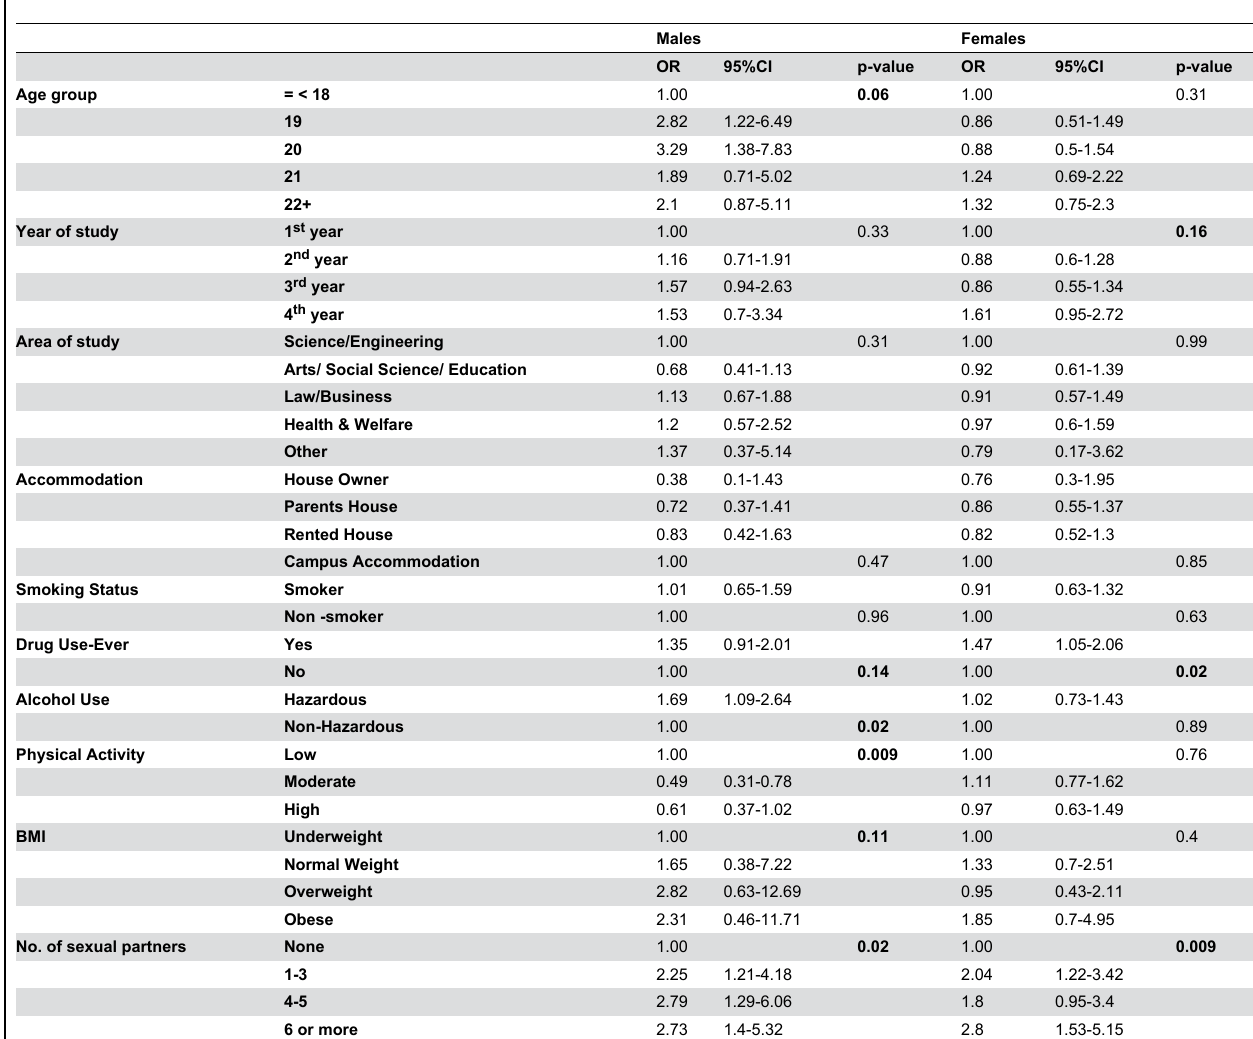
Table 3. Univariate Logistic Regression: Risk factors associated with above average mental health and